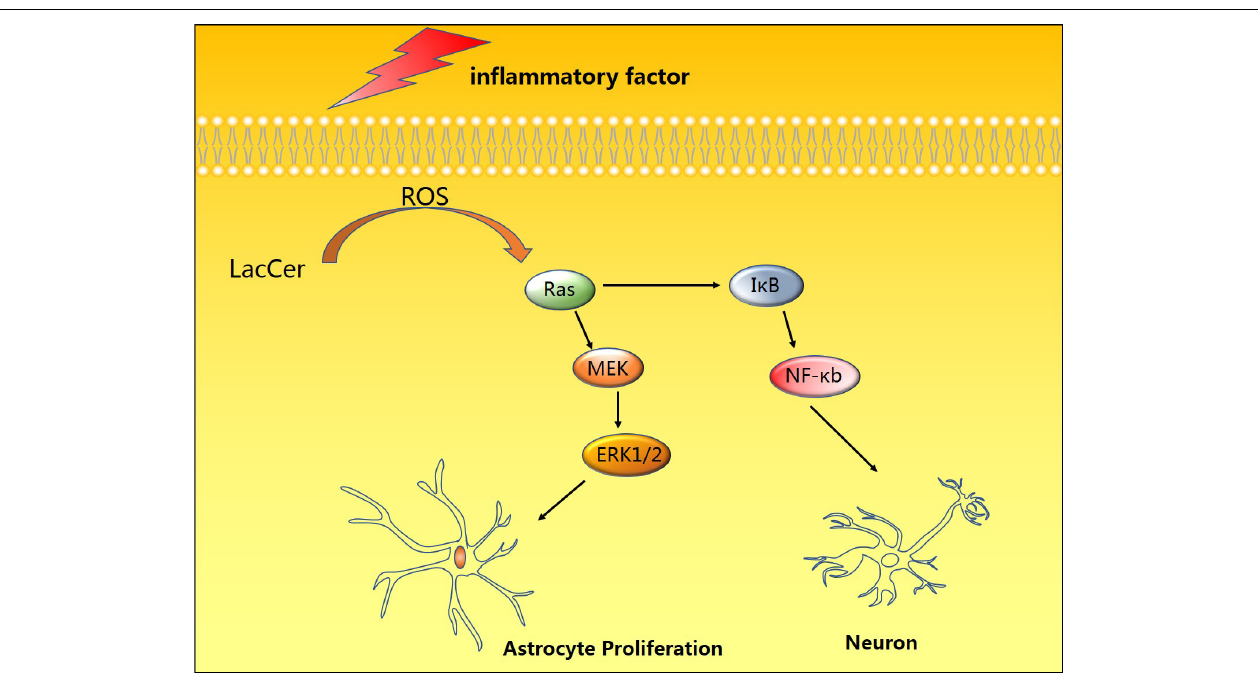
FIGURE 1 | Induction by pro-inflammatory factors and toxic substances can promote the accumulation of LacCer in cells, thereby activating the Ras-MEK-ERK1/2 and I κ B/NF- κ B pathways to promote astrocyte proliferation and neuronal